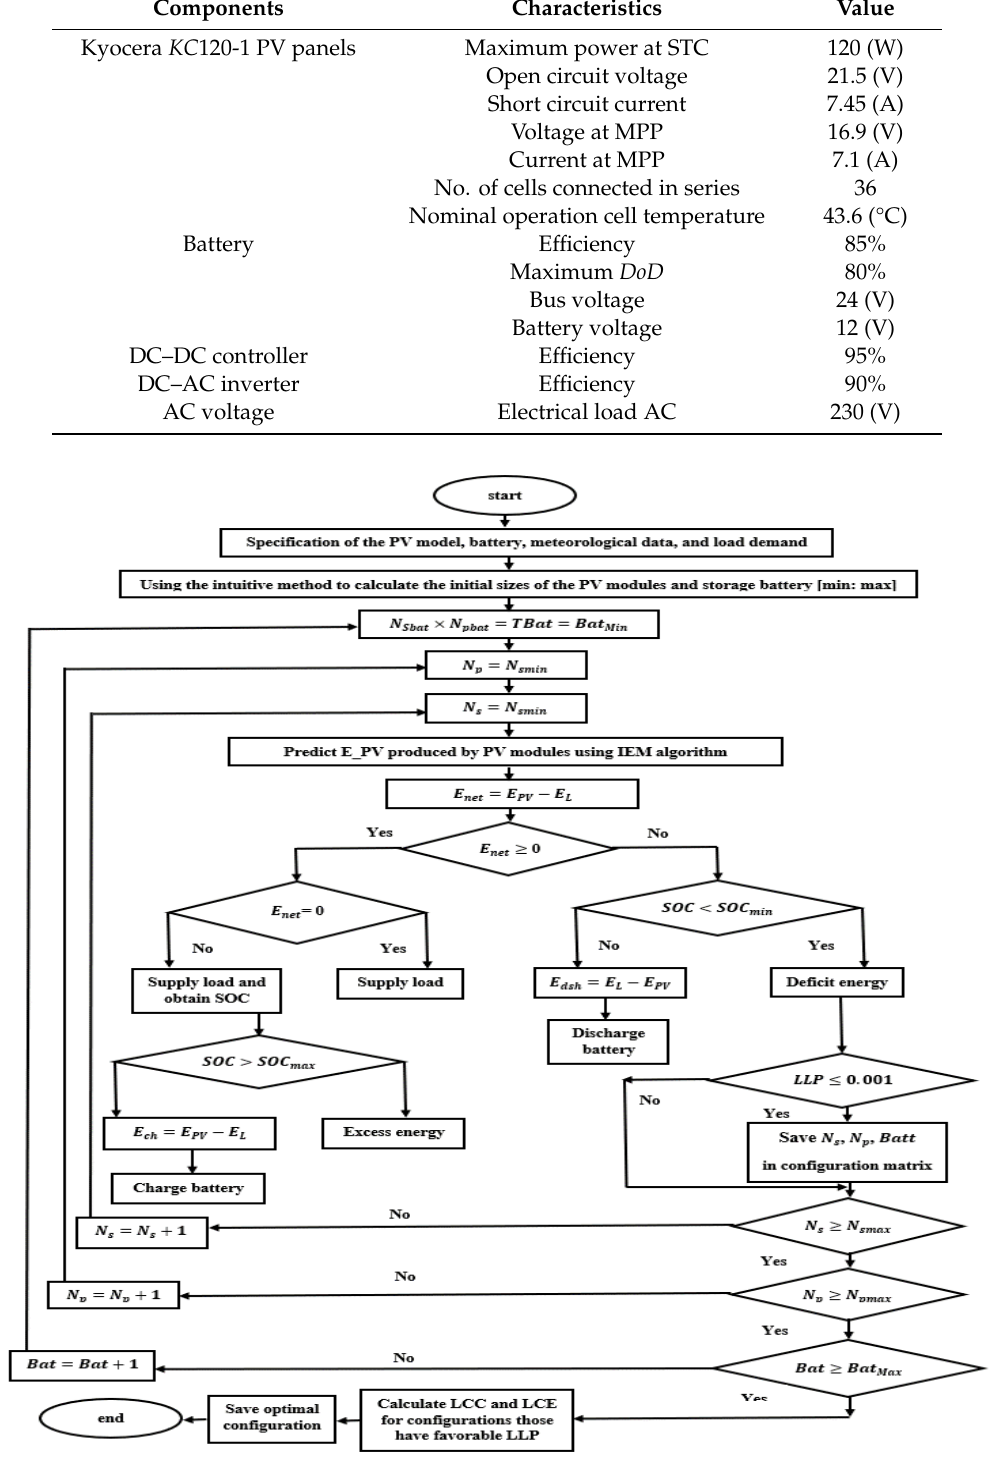
Figure 5. Flow chart of the proposed sizing numerical method of the SAPV system.